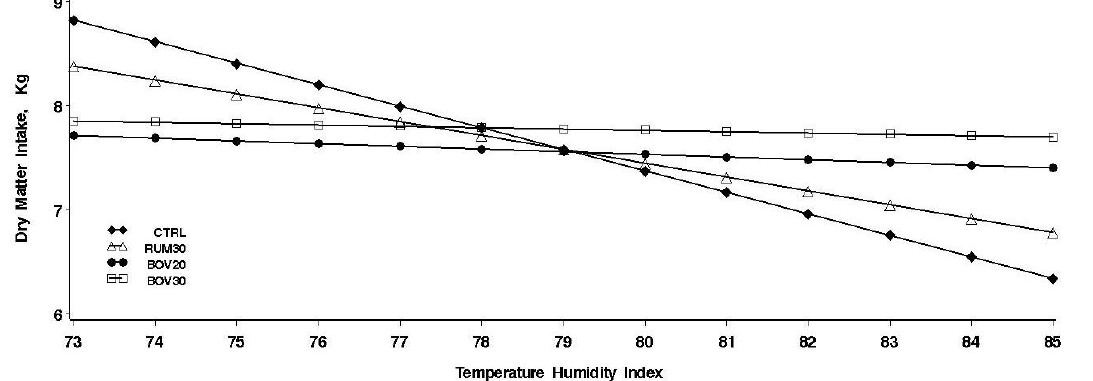
Figure 1. Average dry matter intake relative to the temperature humidity index (THI) measured during the experiment. Treatments are: CTRL = Control, RUM30 = Monensin 30 mg/kg, BOV20 = Lasalocid 20 mg/kg, BOV30 = Lasalocid 30